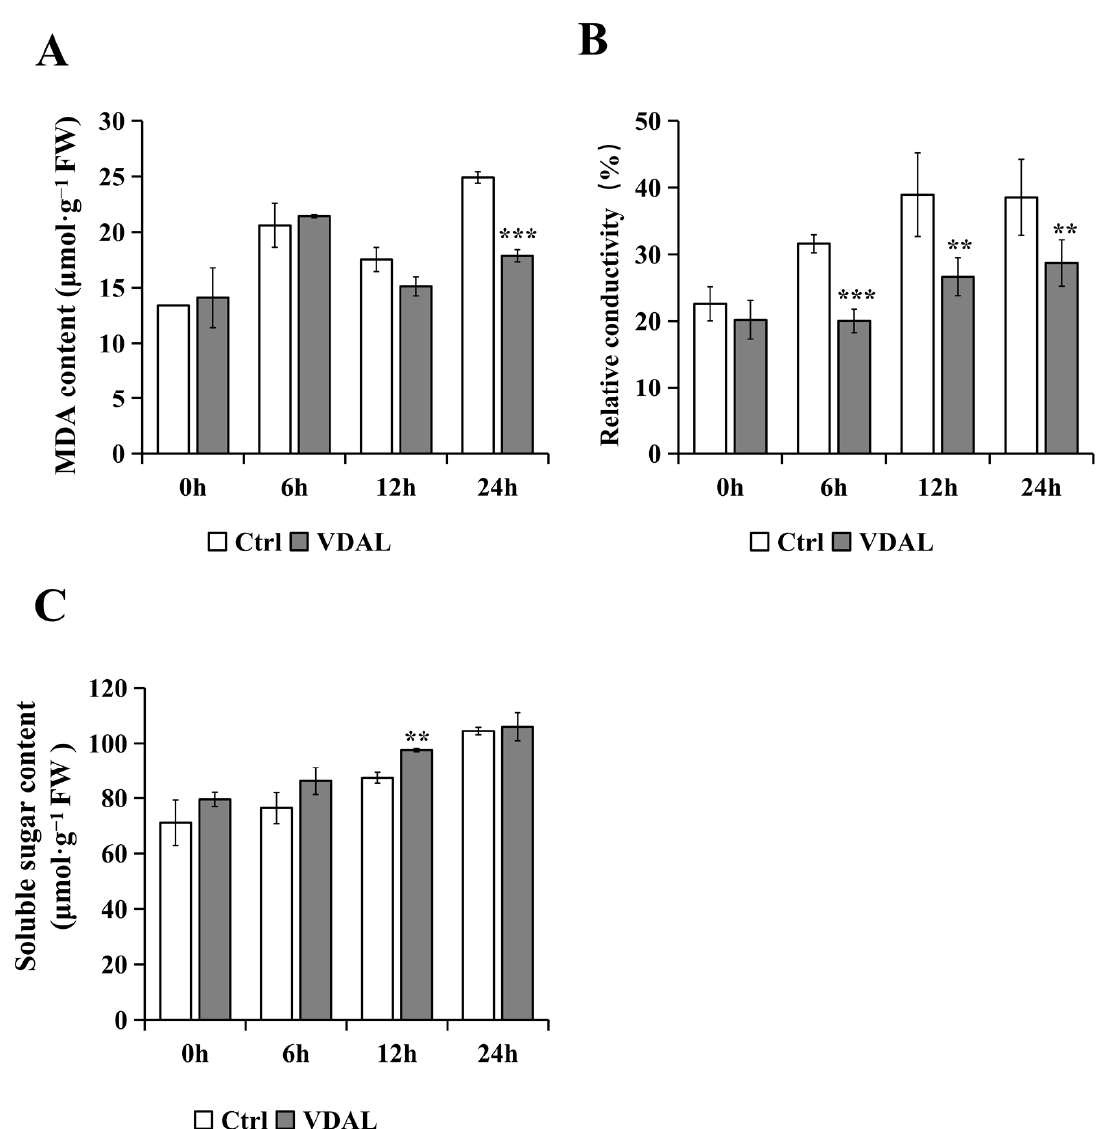
Figure 5. Injury related indicators of B. rapa inoculated with S. sclerotiorum after spraying with water or 1 g ∙ L − 1 VDAL. ( A ) MDA content of B. rapa at 0, 6, 12, and 24 h after inoculation. ( B ) relative conductivity of B. rapa at 0, 6, 12, and 24 h after inoculation. ( C ) soluble sugar content of B. rapa at 0, 6, 12, and 24 h after inoculation. Three independent replicates were performed for MDA and soluble sugar. Six independent replicates were used for relative conductivity. Student’s t -test (** p < 0.01; *** p < 0.001) was used to estimate significant